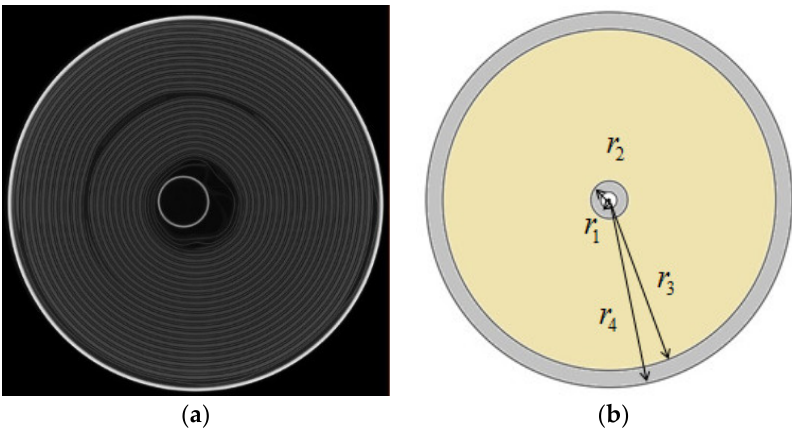
Figure 2. ( a ) The CT image of cross-section of as-received battery; ( b ) the equivalent model of battery.